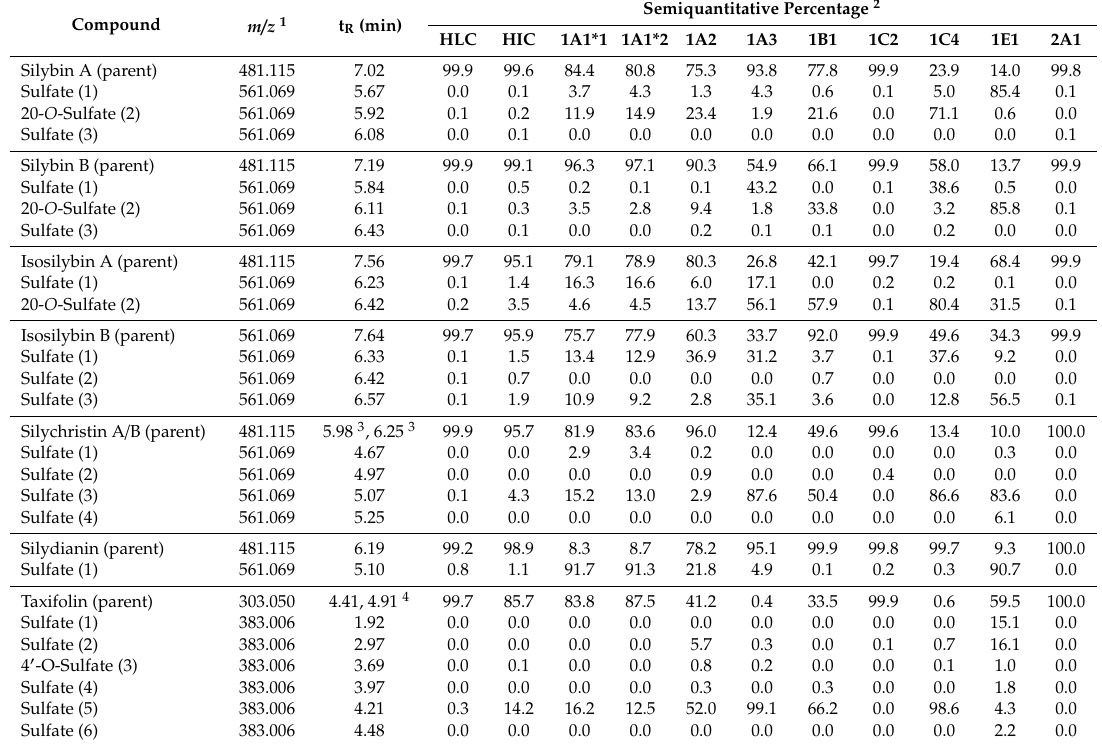
Semiquantitative Percentage 2 HLC